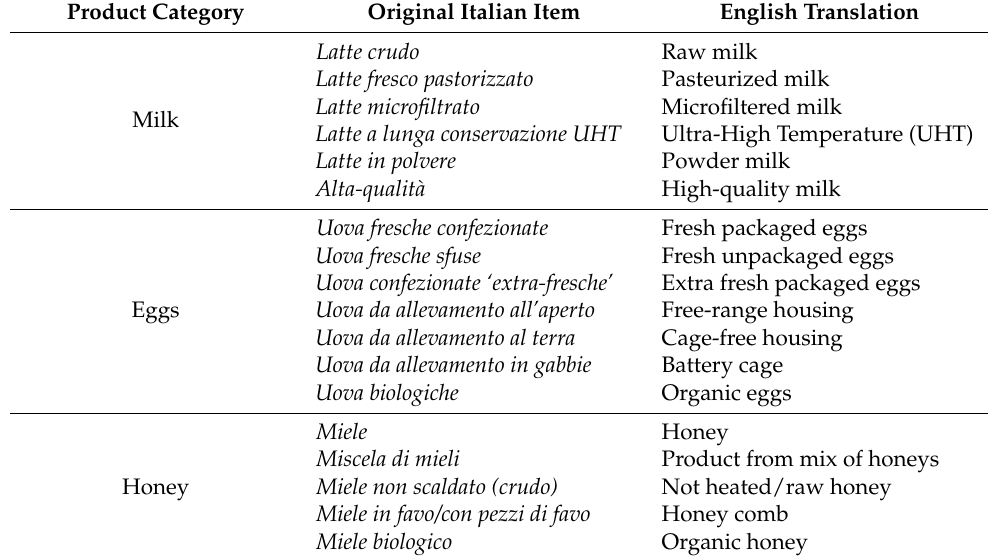
Table 1. Product categories and commercial types considered to evaluate the participants’ perceived